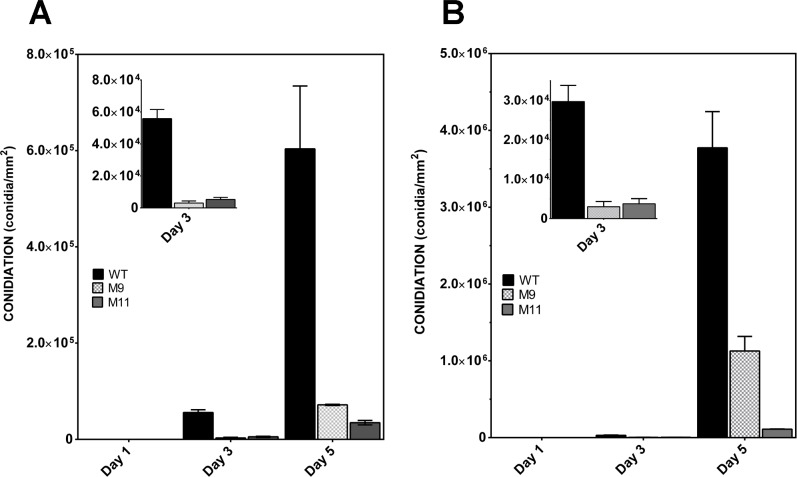
Conidial production of P. roqueforti CECT 2905 (WT) and transformants M9 and M11.Measurements were performed in two different media: Czapek minimal medium (A) and Power (B), a medium optimized for sporulation. Fungi were grown for 1, 3 and 5 days, and spores were collected as described in Materials and Methods. Error bars represent the standard deviation of three replicates in three independent experiments. For a clearer visualization, day 3 is also shown as an inset plot in A and B. Conidial production of P. roqueforti containing empty pJL43-RNAi vector was statistically indistinguishable from the wild-type strain (not shown).